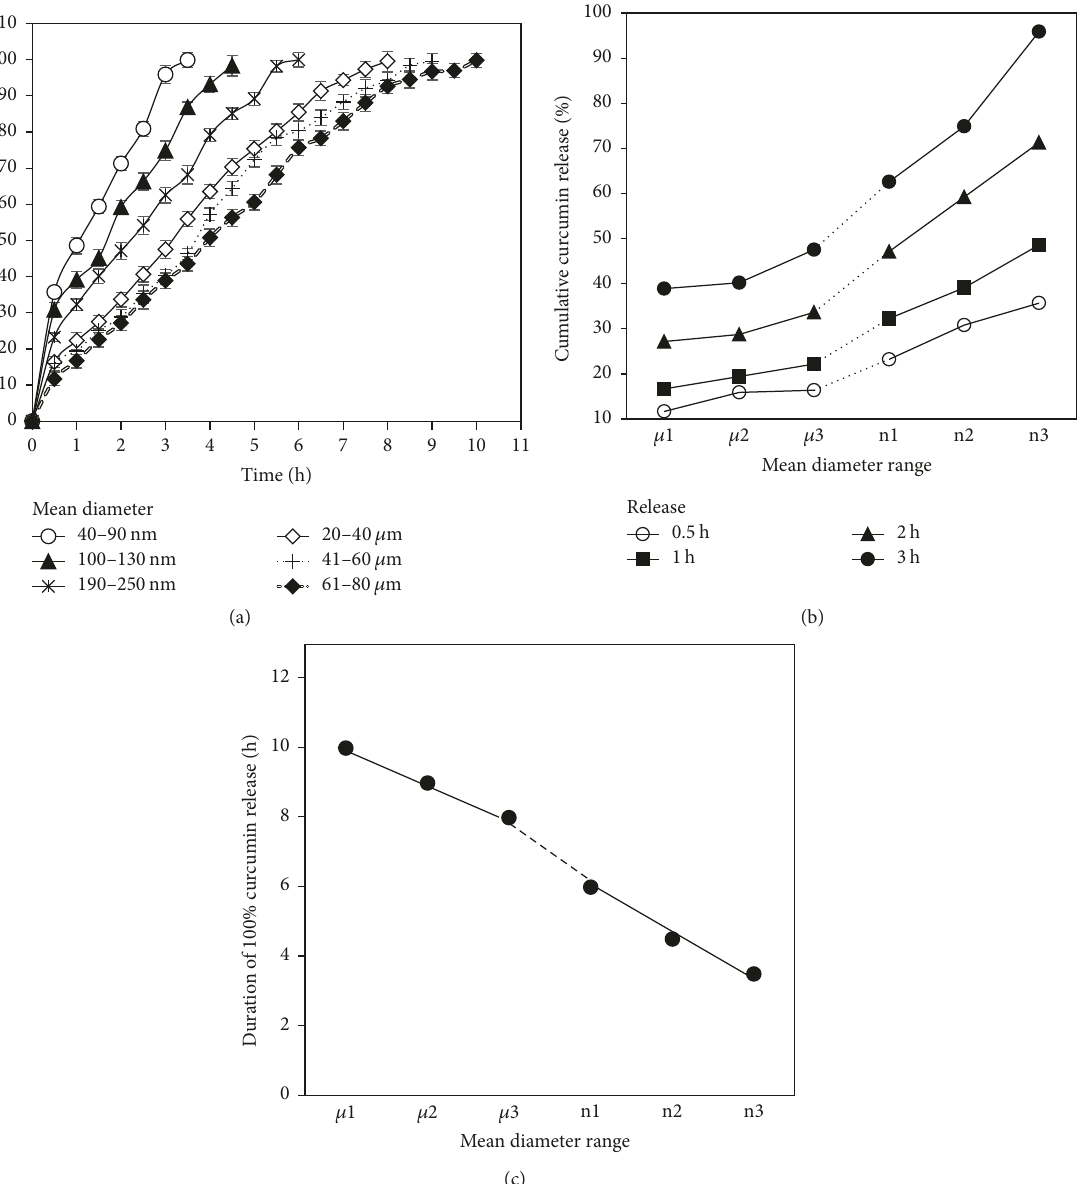
Figure 6: (a) Release kinetic profiles of curcumin from cellulose beads of different mean diameter ranges, (b) cumulative percentage of curcumin released from cellulose beads of various mean diameter ranges at different time intervals, and (c) durations for 100% curcumin released from cellulose beads of different mean diameter ranges ( 𝜇 1: 61–80 𝜇 m, 𝜇 2: 41–60 𝜇 m, 𝜇 3: 20–40 𝜇 m, n1: 190–250 nm, n2: 100–130 nm, and n3: 40–90